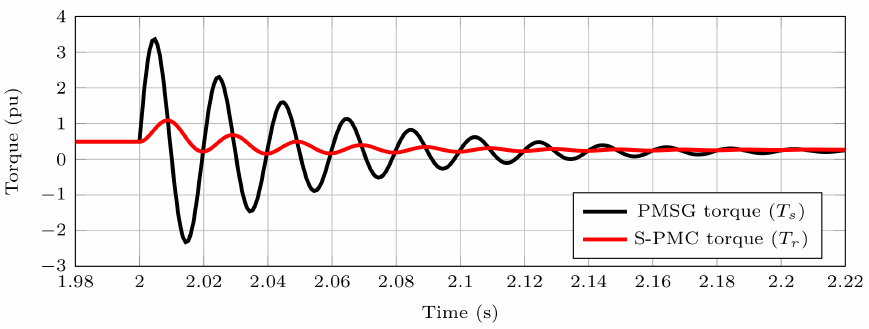
Figure 7. Short-circuit torque responses of the PSMG and the S-PMC during the time period t = 1.98 s to t = 2.22 s of the LVRT event in Figure 6.